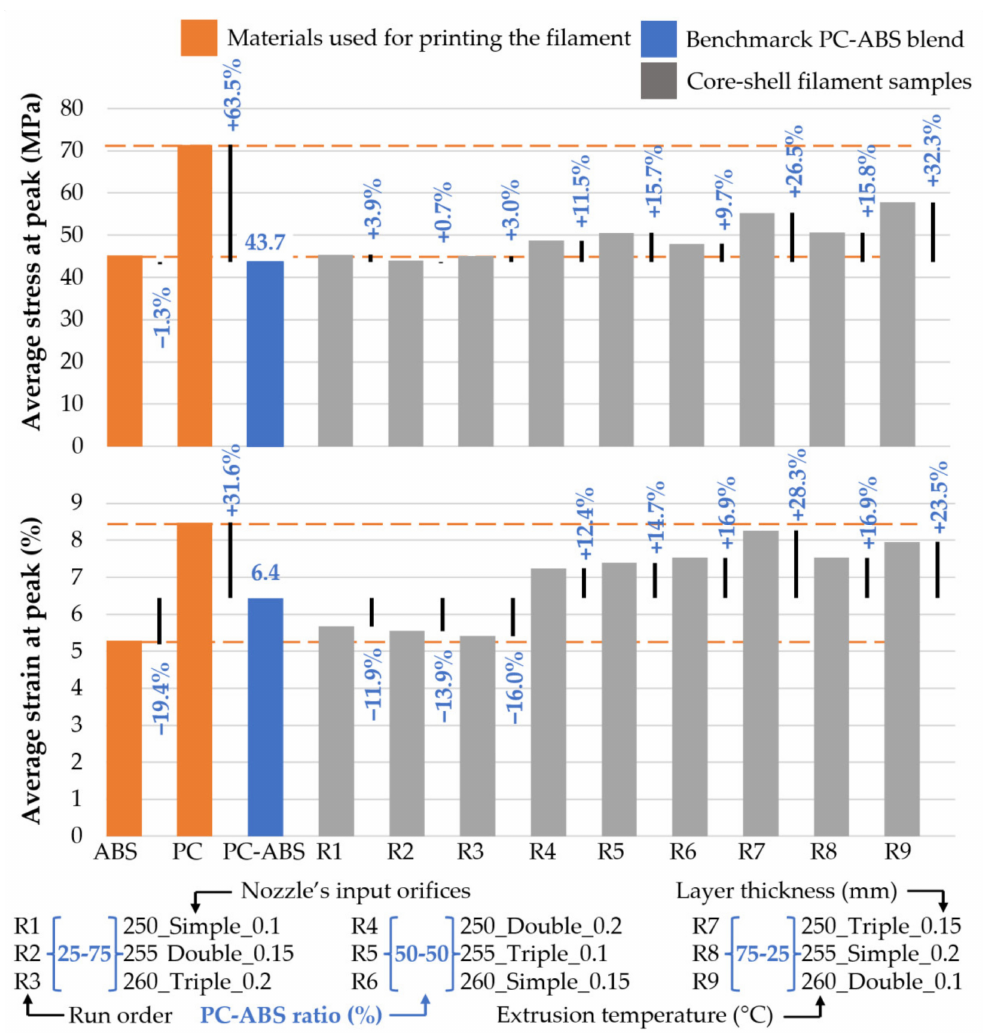
Figure 7. Average tensile stress and strain at the peak of the experimental run specimens referred to the PC-ABS bench- mark